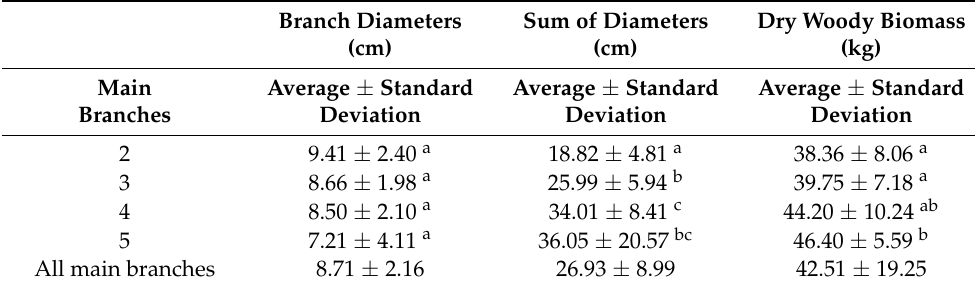
Table 4. Analysis of variance to analyze the influence of the number of branches. "a", "b" and "ab" show the similarity or significant difference between the groups.